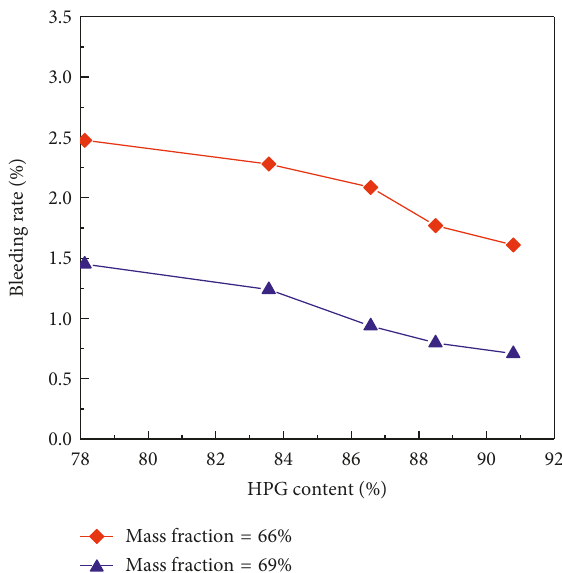
Figure 6: Effect of HPG content on the bleeding rate of backfill slurry. Cement content is 3%.